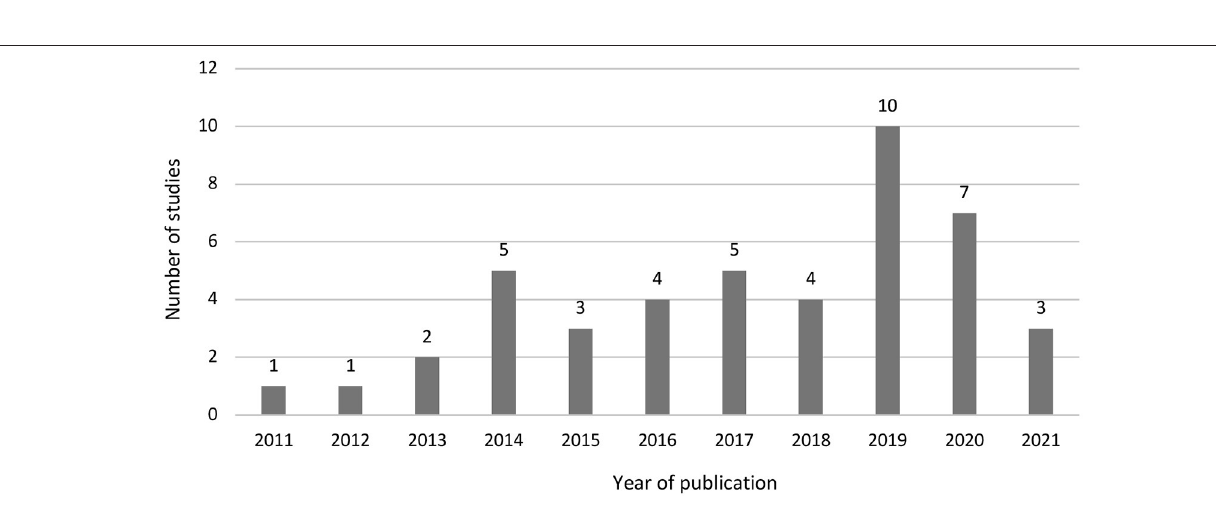
FIGURE 3 | Number of CM studies by